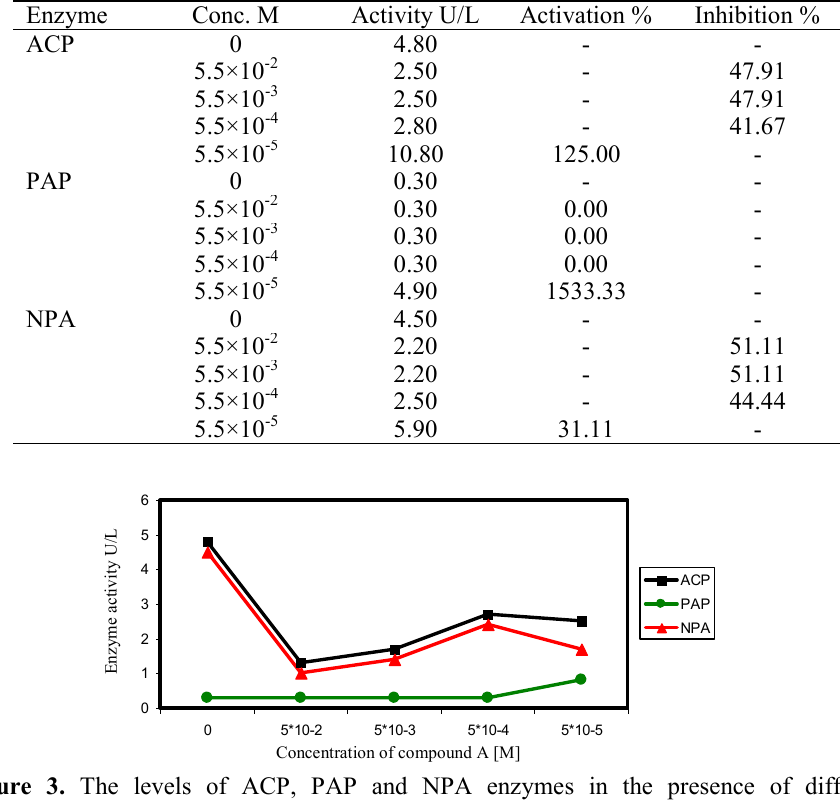
Table 3. The effect of different concentrations of compound B on the activity of ACP, PAP and NPA enzymes.